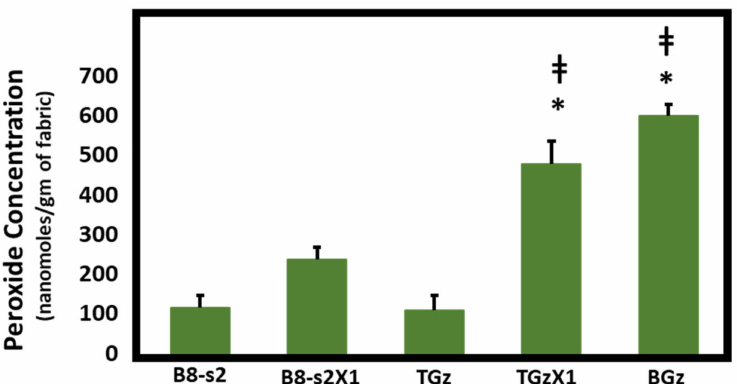
Figure 1. Comparison of hydrogen peroxide production. Fabrics (50 mg) were incubated overnight in 2 mL of H 2 O at room temperature. Aliquots were removed and H 2 O 2 content was determined using the ferrous oxidation-xylenol orange assay in quadruplicate, n = 4. Error bars represent Standard Error of Mean (SEM). Results were analyzed by ANOVA. Post-hoc (Tukey) test demonstrated significantly higher levels of H 2 O 2 production by TACGauze (TGz) treated with citric acid and ascorbic acid or BIOGauze (BGz) versus either bleached cotton (B8-s2) or TGz alone. * p < 0.001 versus bleached cotton. ‡ p < 0.001 versus TGz.